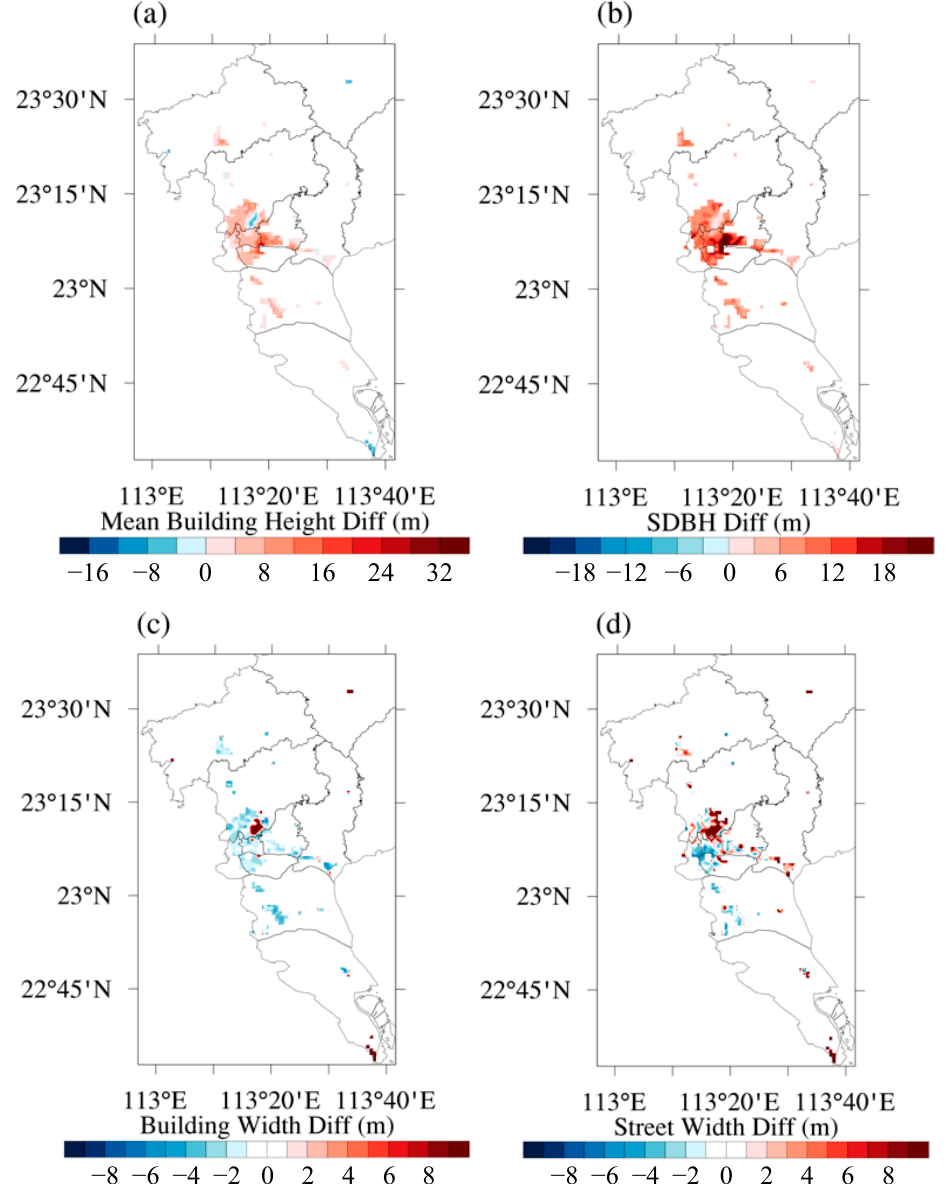
Figure 3. The distribution of local urban morphology (UM) parameters for SLUCM, ( a ) mean building height (default: 5 m); ( b ) standard deviation of building height (default: 0 m); ( c ) building width (default: 8.3 m); ( d ) street width (default: 8.3 m). Table 3. Statistics regarding the urban morphology (UM) in di ff erent districts.